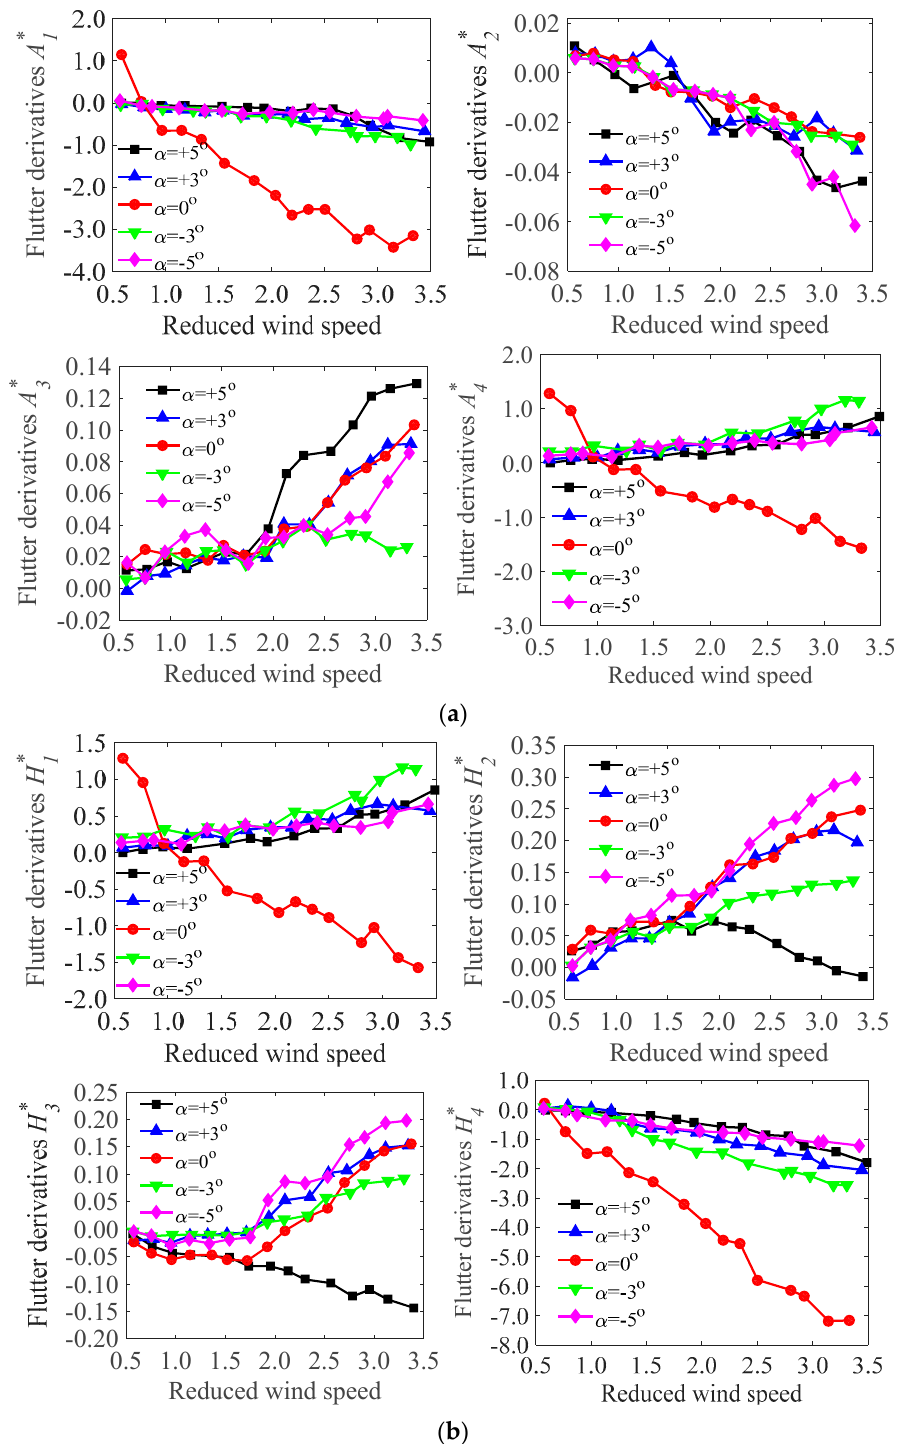
Figure 8. The flutter derivatives of the test model under different wind attack angles in the operation stage: ( a ) flutter derivatives A ∗